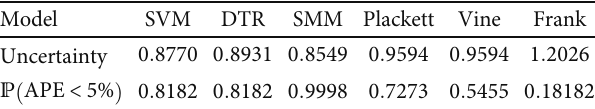
Table 8: Uncertainty and reliability at 95 % con fi dence level. Model SVM DTR